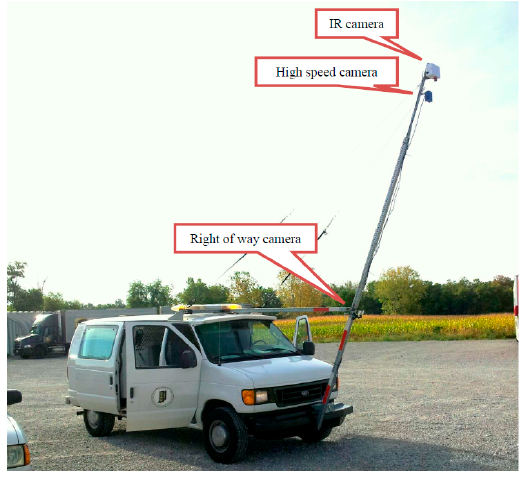
Figure 3. Infrared image collection system.